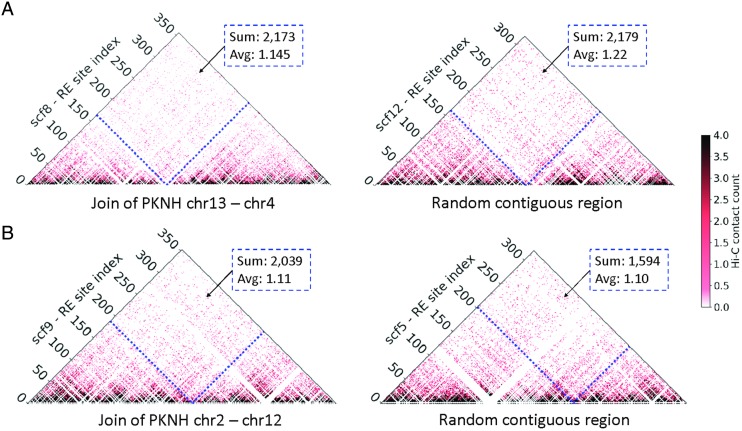
Hi-C contact maps for the join regions present on scaffolds 8 and 9. Hi-C contact
maps of two scaffolds from the PKNOH-PacBio-Hi-C assembly that contain contigs
previously assigned to two different chromosomes in the PKNH assembly. These contact
maps are zoomed in to the join regions and are at the single MboI restriction
fragment level (~1 kb in resolution). Each heatmap is rotated 45 degrees compared
with previous intracontig/scaffold heatmaps for visualization purposes. (A) The
200 kb region of scaffold 8 (scf8:500 000– 700 000) that surrounds the join (at
scf8:593 400) between two contigs previously assigned to chr13 and chr4 (left)
compared with a matched 200 kb region from scaffold 12, which consists of a single
contiguous PacBio contig (right). (B) Similar case vs control
figure for scaffold 9 compared with matched coordinates in scaffold 5. The dashed
blue lines correspond to location of the join (or matching coordinates on the right)
and the sum and average number (excluding zeros) of interactions between the left
and right (rectangular area) of a join are reported for each case.